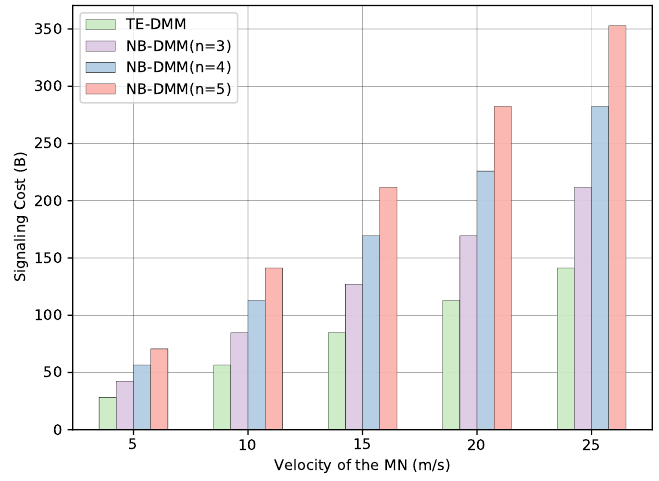
Figure 6. Signaling cost depending on velocity of the MN.